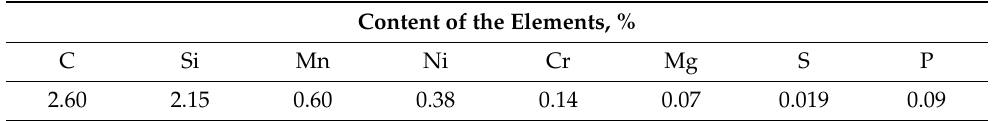
Table 1. Chemical composition of cast iron.